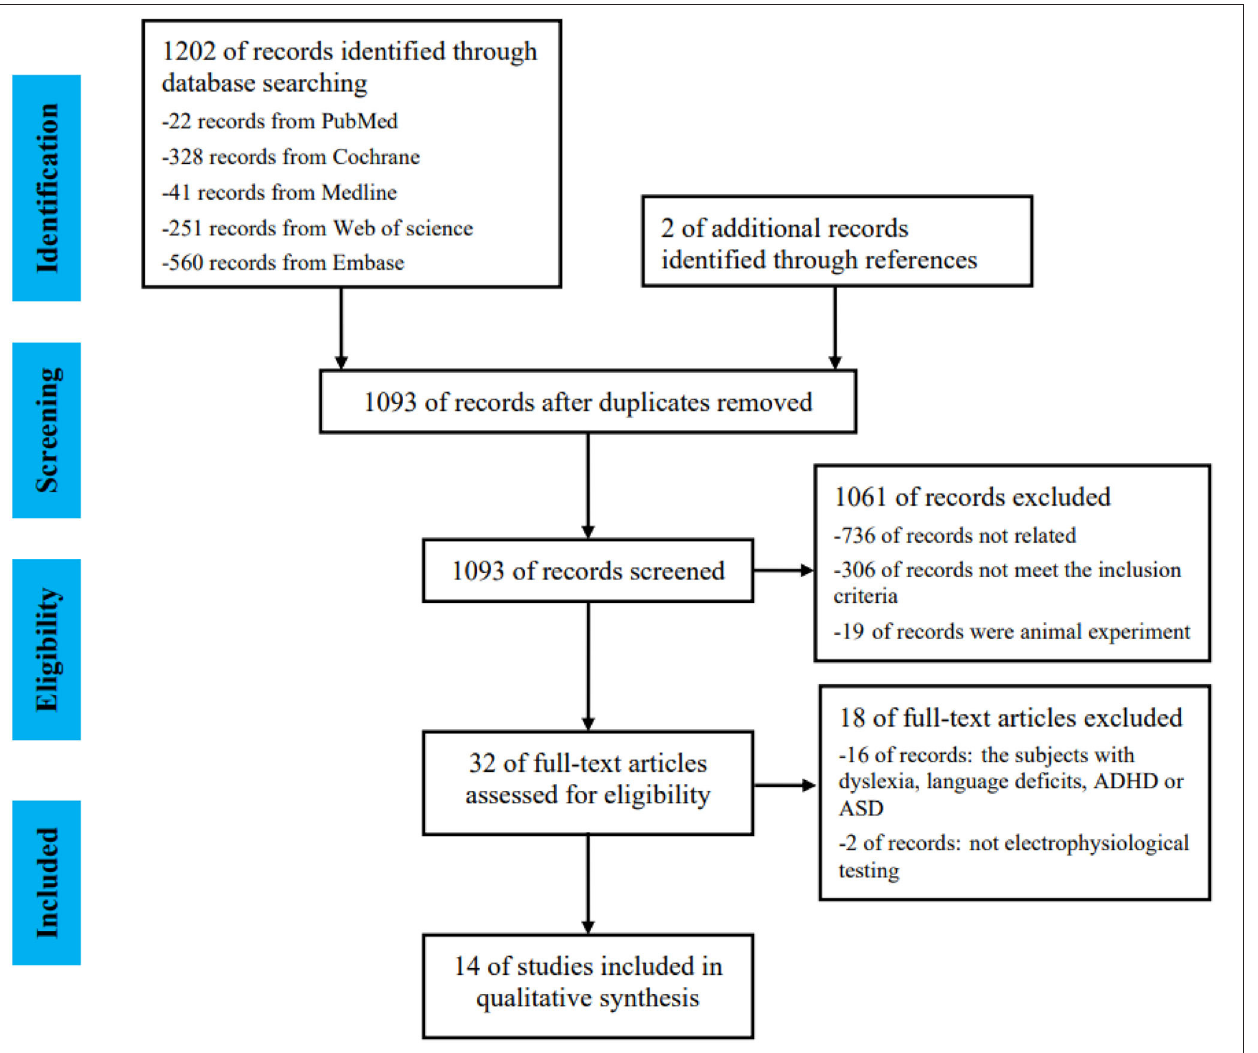
Frontiers in Neurology |